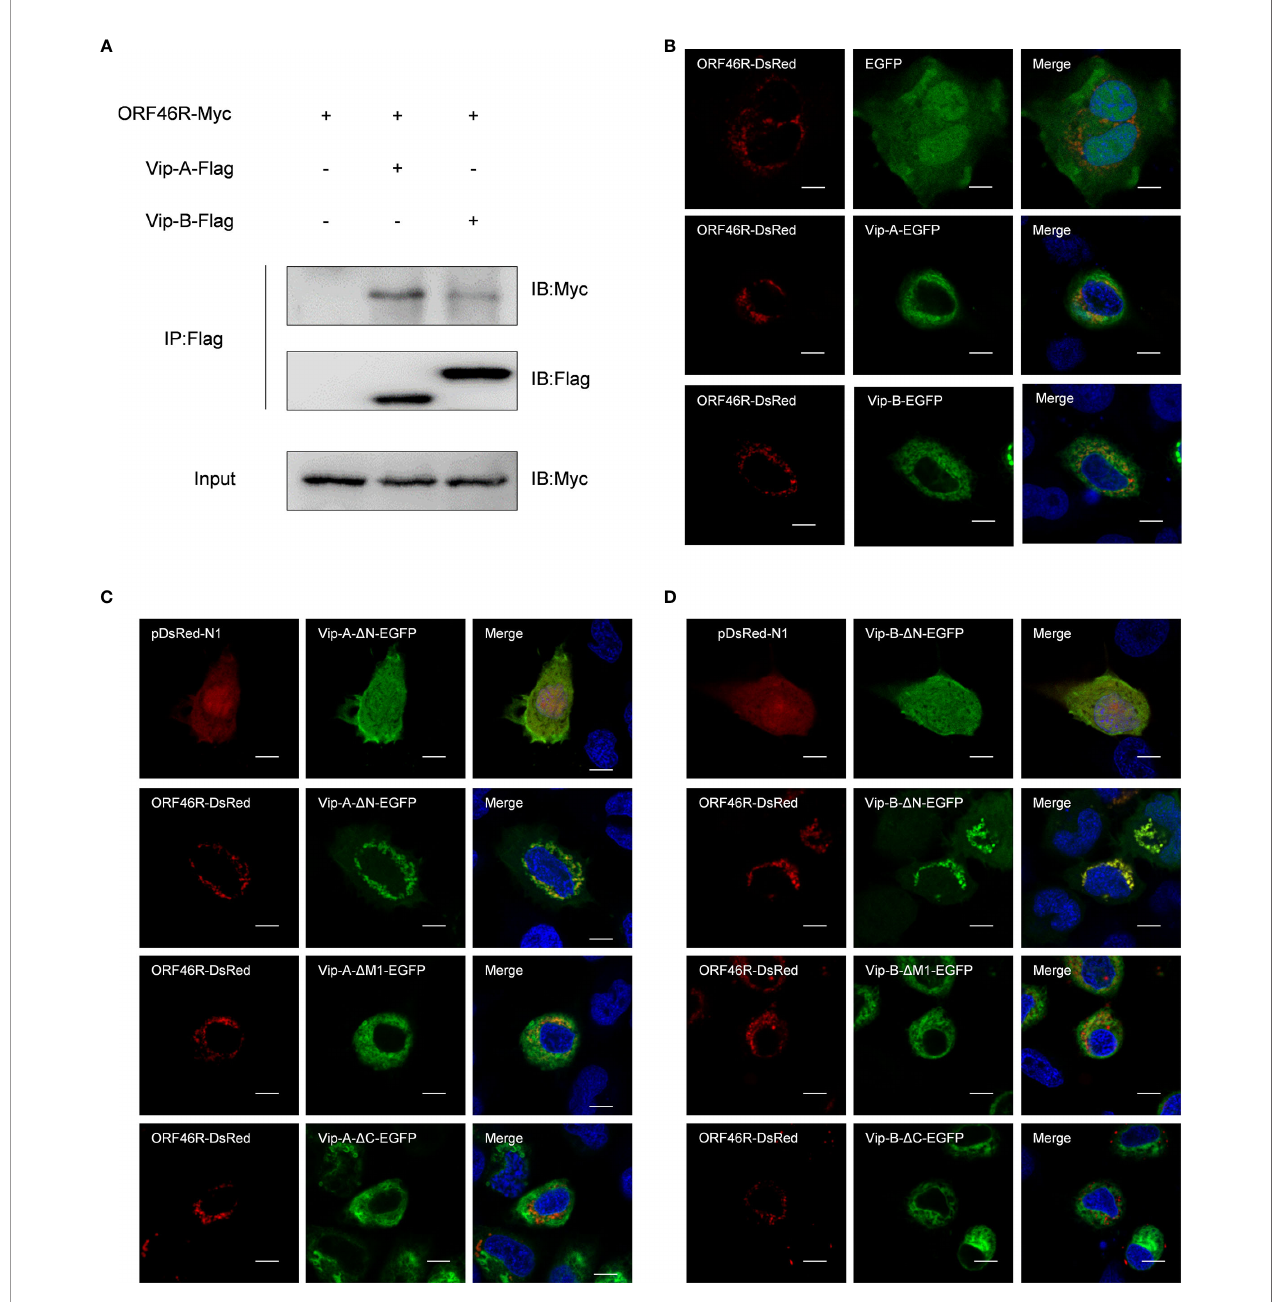
FIGURE 4 | Both Cg Viperin-A and Cg Viperin-B interact with ORF46R of Ca HV. (A) Co-IP of Vip-A-Flag or Vip-B-Flag with Myc-ORF46R in CAB cells transfected with the indicated plasmids. Anti-Flag Ab was used for Co-IP. (B) Subcellular localization of WT Cg Viperin-A, Cg Viperin-B, and ORF46R. CAB cells were plated onto coverslips in six-well plates and co-transfected Cg Viperin-A-EGFP or Cg Viperin-B-EGFP with ORF46R-DsRed. After 24 h, the cells were fi xed and observed under confocal microscopy. Nuclear was stained with DAPI. Scale bars = 5 m m. (C, D) Subcellular localization of three mutants of Cg Viperin-A or Cg Viperin-B with ORF46R-DsRed. Scale bars = 5 m